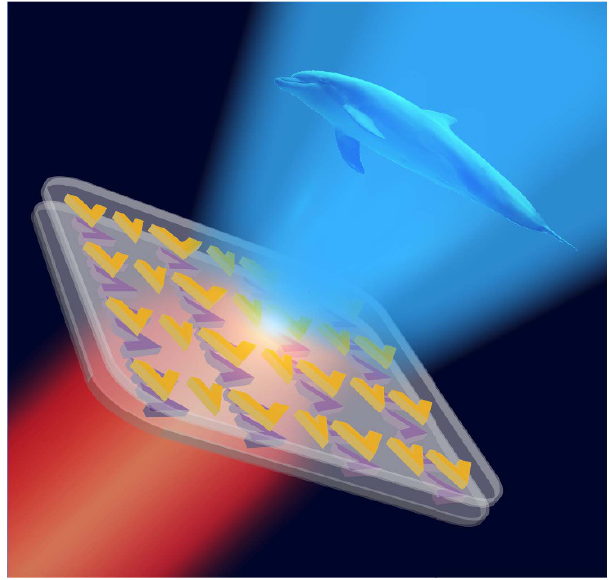
Figure 1 | Artist’s concept of a multilayer nonlinear metamaterial hologram. When the hologram is illuminated by an infrared laser, it generates a holographic image of an object at the third harmonic frequency in the